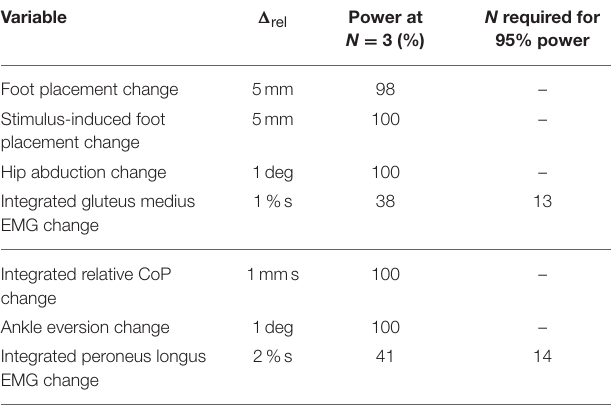
TABLE 1 | Results of the power